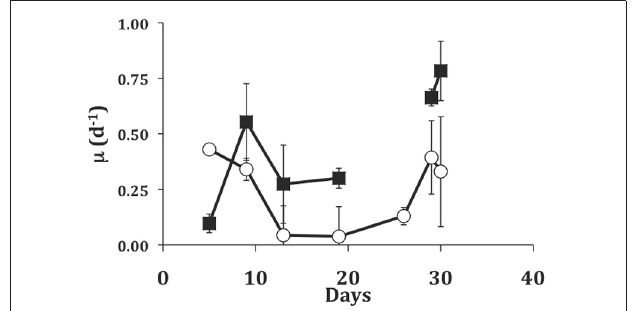
FIGURE 5 | Growth of S. rassoulzadegani on a diet of the dinoflagellate Prorocentrum minimum (EXUV) when incubated in dark (closed squares) or light (open circles). Symbols represent means of growth rate in the preceding interval, with standard deviations of triplicates. The gap in the dark treatment occurred when two of three replicates suffered 100% mortality, so the last two points in the dark treatment are ciliates transferred from the surviving well.